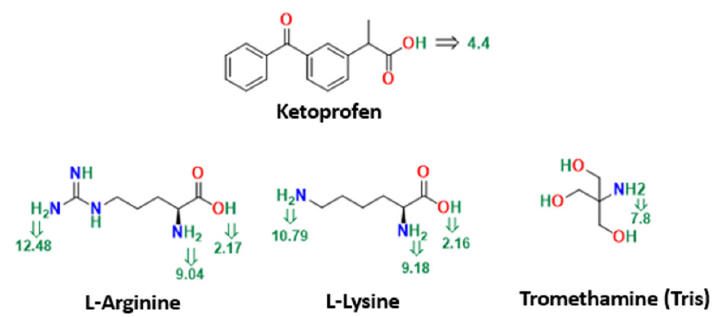
Figure 1. Structures and pKa values of ketoprofen, tris, L ‐ lysine, and L ‐ arginine.